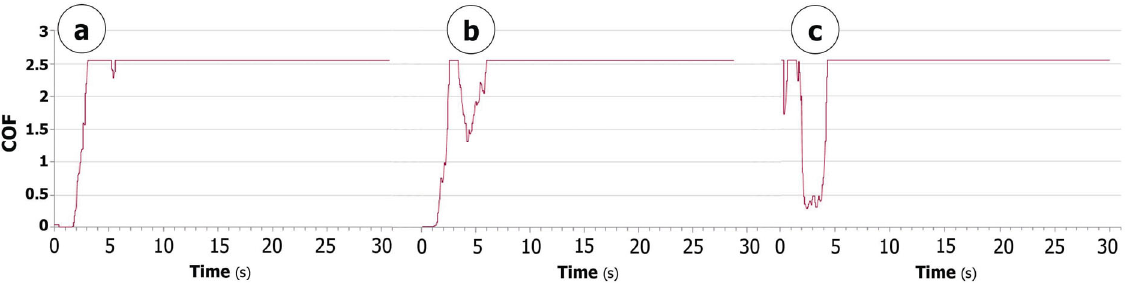
Fig. 7 Evolution of the COF during the hBN lubricated tribotest for the as-received (a) tool steel A, (b) tool steel V, and (c)